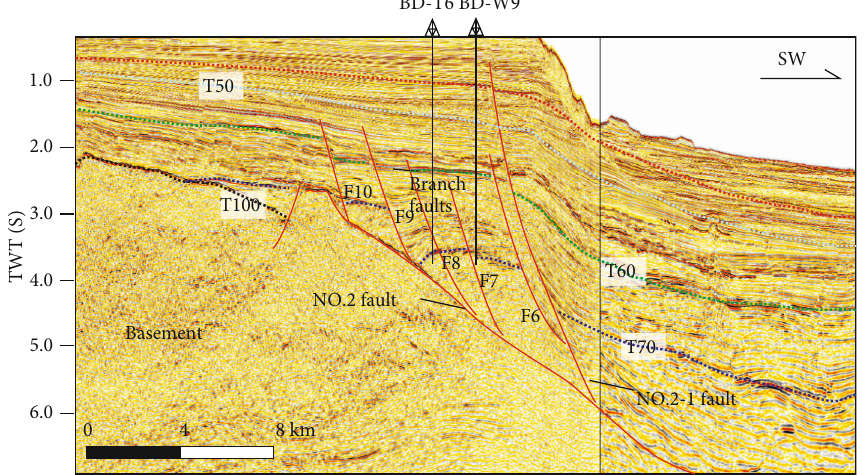
Figure 9: The SW-oriented seismic section (L3) of the BD19 gas reservoir reveals that the No. 2 fault is characterized by a branching structure in the BD19 area. There are many secondary faults in the hanging wall close to the main section of the No. 2 fault. The section location is shown in Figure 1. Our 3D seismic data extend as deep as